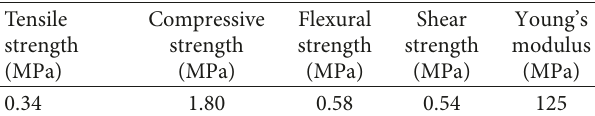
Figure 1: Gypsum panels used as infill walls [18]. (a) A view of two panels. (b) A specimen under compression test. Table 1: Average mechanical properties of the gypsum